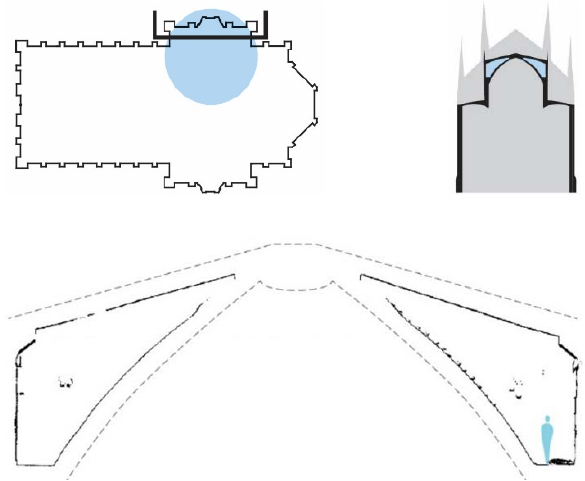
Figure 2. Localisation of the “sordine” spaces, plan view (left), section (right) and a detail of the section